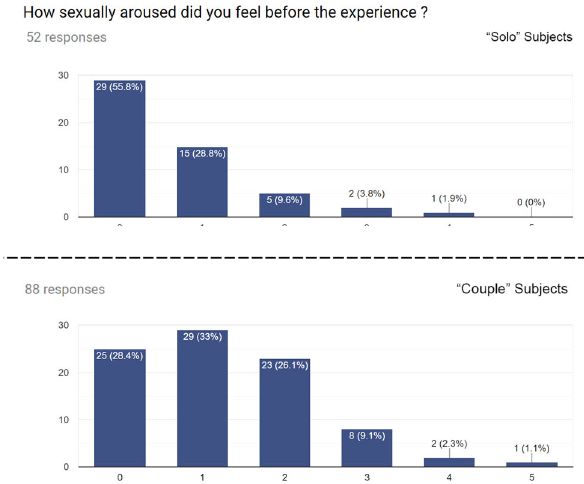
Figure 10: Charts indicating arousal level before the experience in “ Solo ” ( above ) and “ Couple ” ( below ) subjects extracted from the self - report forms.